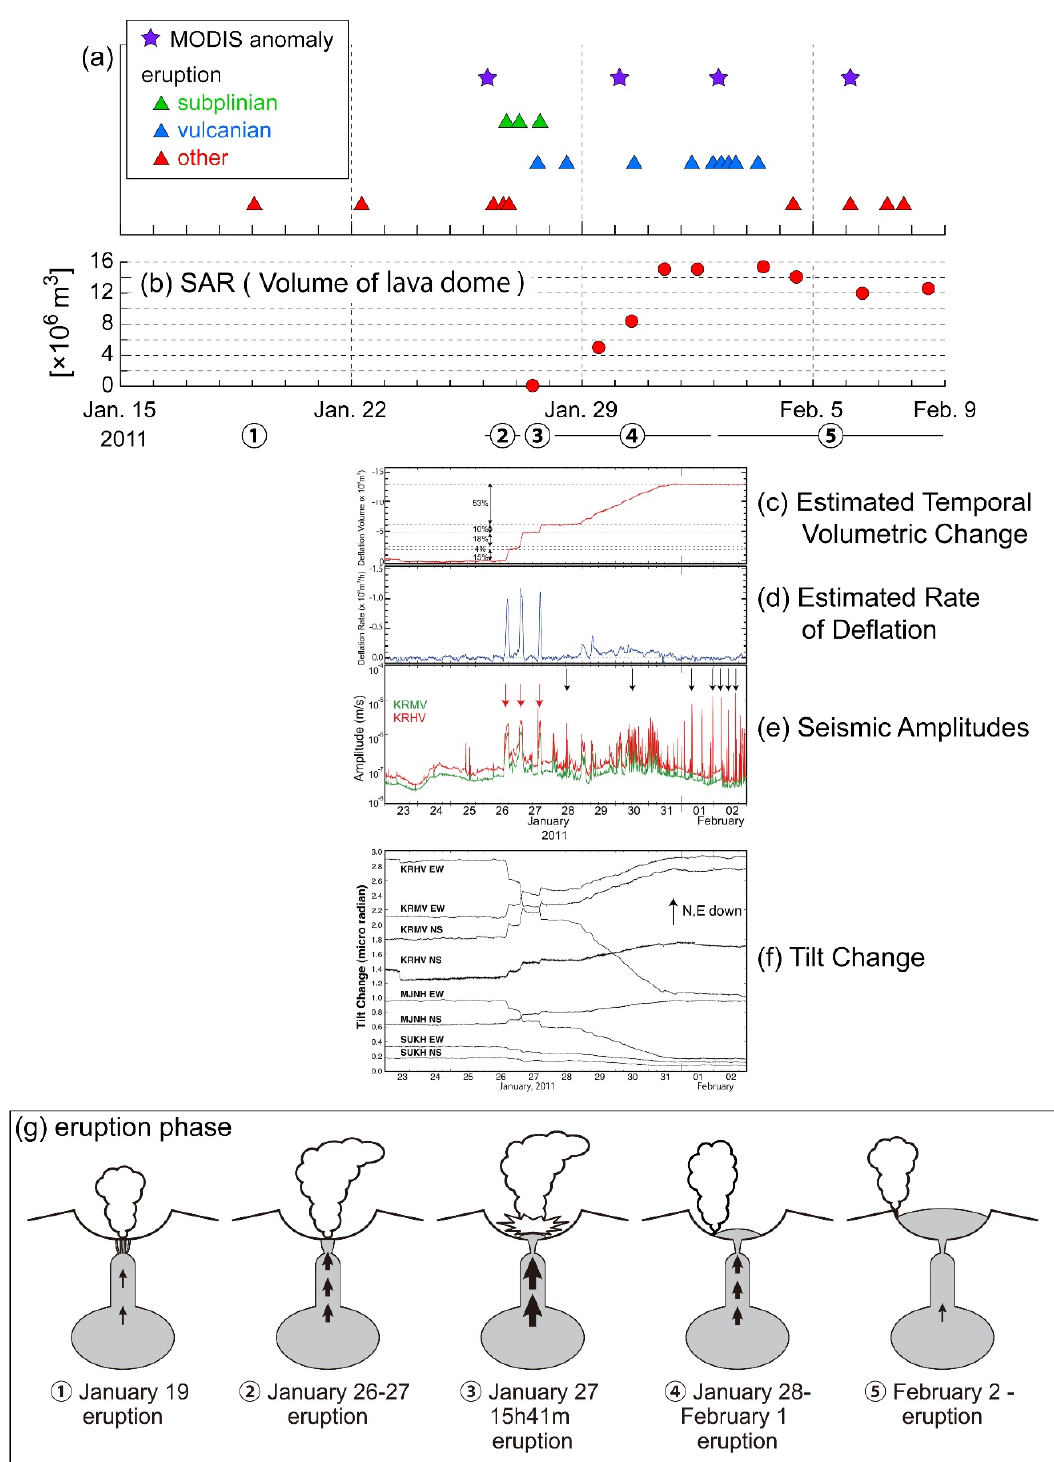
Figure 11. Schematic view of the 2011 Shinmoedake volcanic activity from January to February 2011 in LT [27–33]. ( a ) Timing of MODIS anomaly and the timing and type of eruptions; ( b ) temporal variation of lava dome volume obtained from satellite SAR data; ( c ) erupted lava volume estimated by tiltmeter data shown in panel ( f ); ( d ) deflation rate of lava; ( e ) variation of 10 min average value of the amplitude of seismometer; ( f ) tiltmeter data near the Shinmoedake and ( g ) schematic view of lava activity of the 2011 Shinmoedake activity. Arrows in the magma indicate the intensity of the effusion rate.